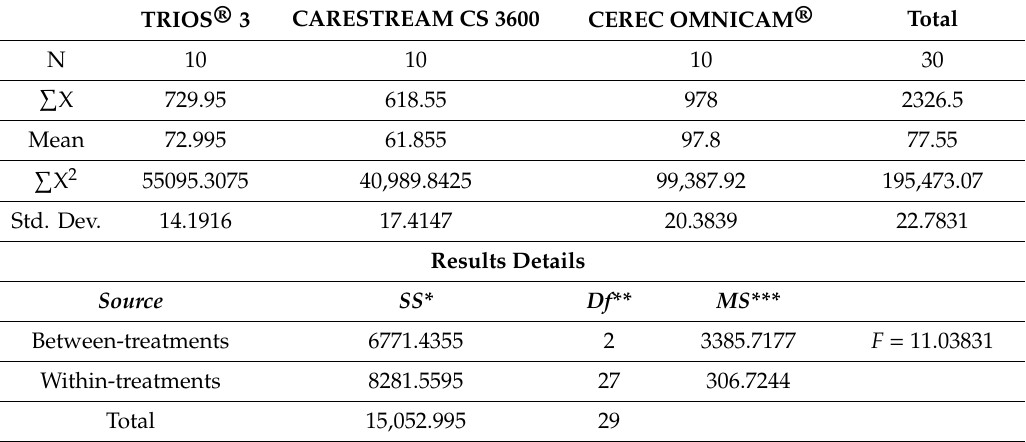
Table 7. Distance between reference lines and test ones in sample 2 without